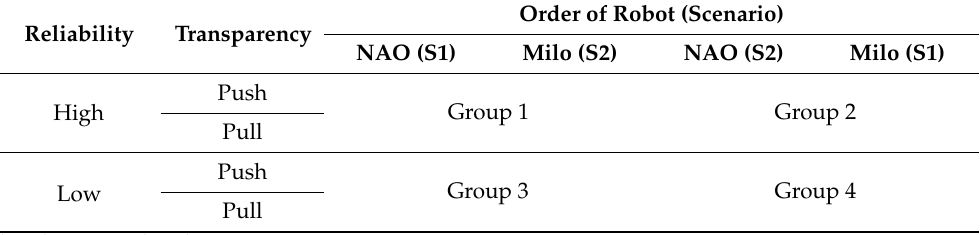
Table 3. Experiment design